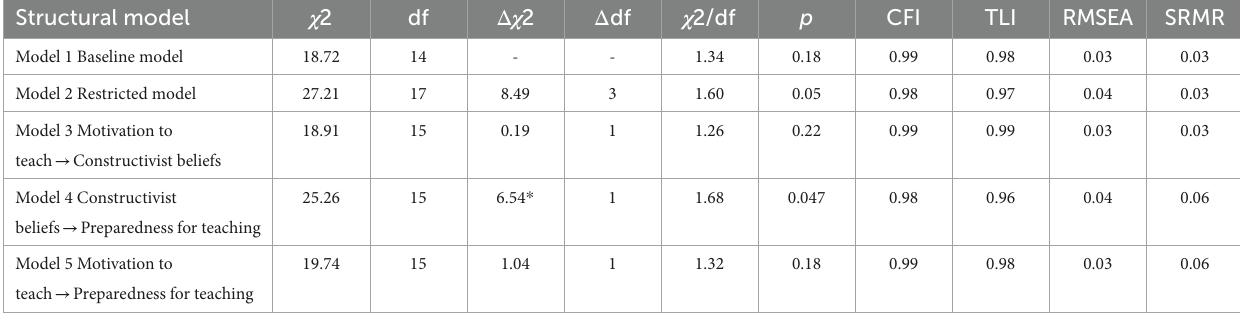
TABLE 3 Multigroup analysis: Testing for path coefficients invariance across high and low score group conscientiousness ( N = 383). Structural model